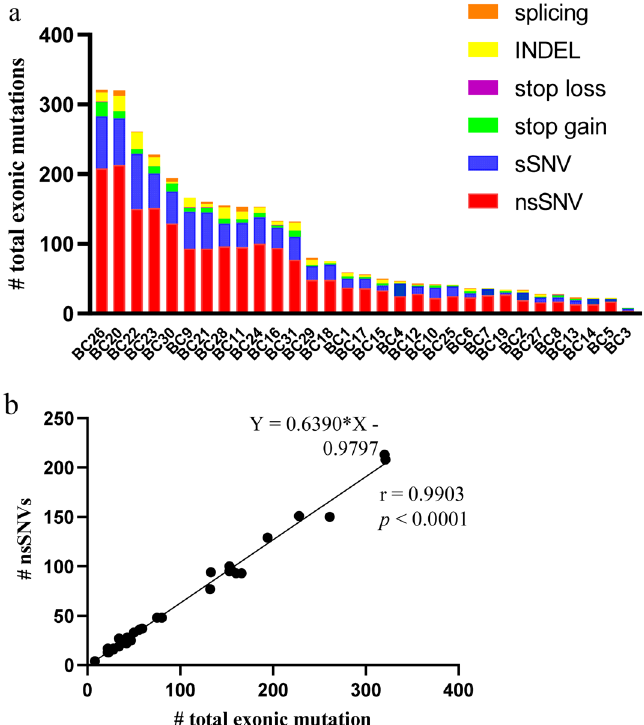
Figure 1. Exonic mutation landscape in breast cancer determined by whole exome sequencing of tumour tissues and peripheral blood mononuclear cells. ( a ) The numbers of total exonic mutations and mutation types in the 31 breast cancer patients. ( b ) The number of total exonic mutations was highly correlated to the number of nsSNVs. INDEL: insertion/deletion; sSNV: synonymous single nucleotide variant; nsSNV nonsynonymous single nucleotide